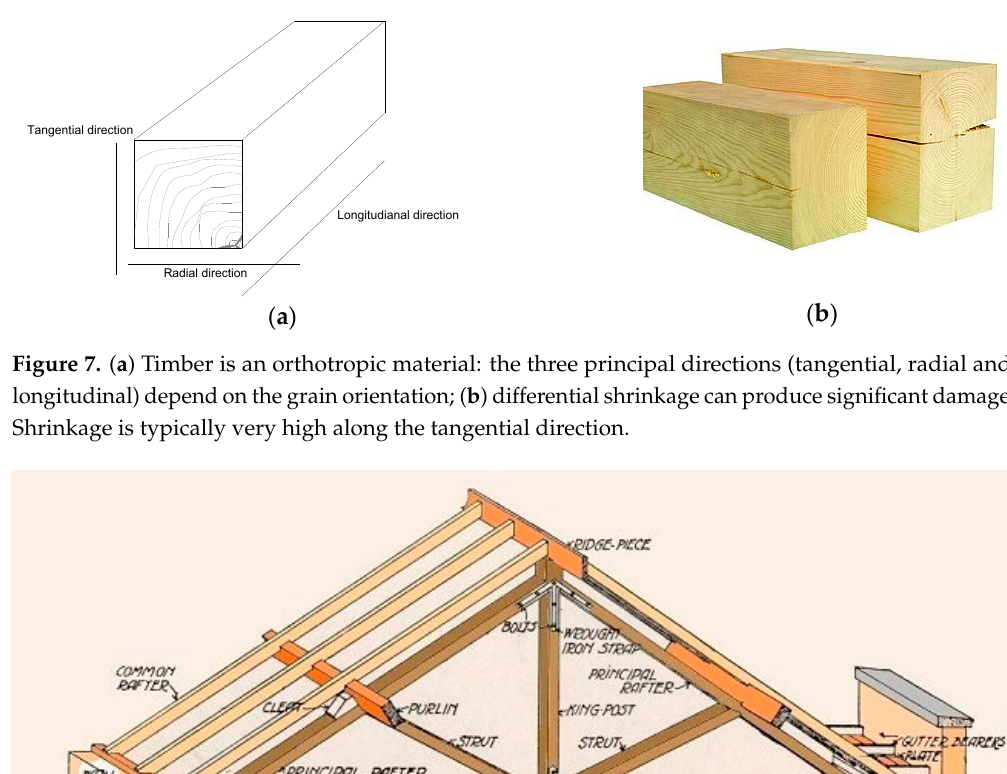
Figure 8. Symbols and terminology used for structural members of the traditional king post roof truss [36].